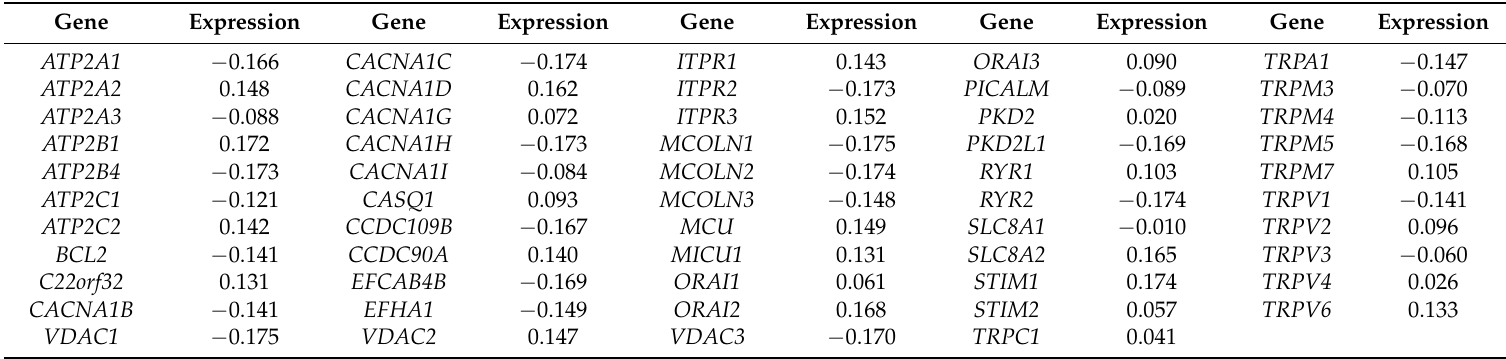
Table 2. Coefficient values from Principal Component (PC1) corresponding to each gene. Raw data were transformed, filtered, centered and standardized. To obtain PC1 value for a given sample, use coefficients in this table in expression